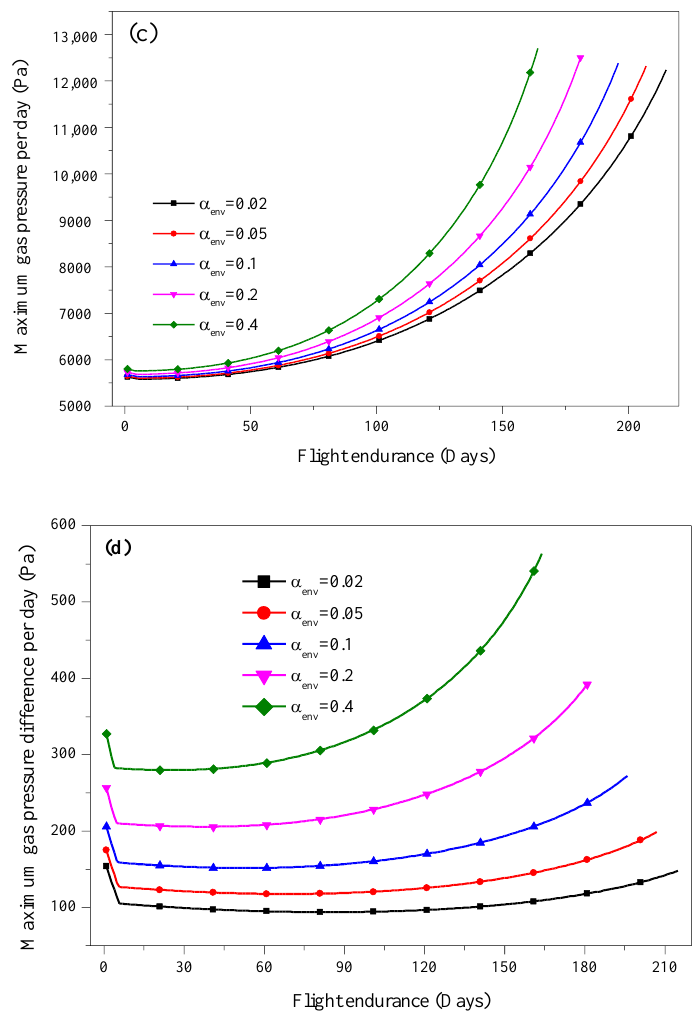
Figure 16. Effects of envelope absorptivity on the ( a ) maximum skin temperature per day, ( b ) maximum gas temperature per day, ( c ) maximum gas pressure per day, and ( d ) maximum gas pressure difference per day.